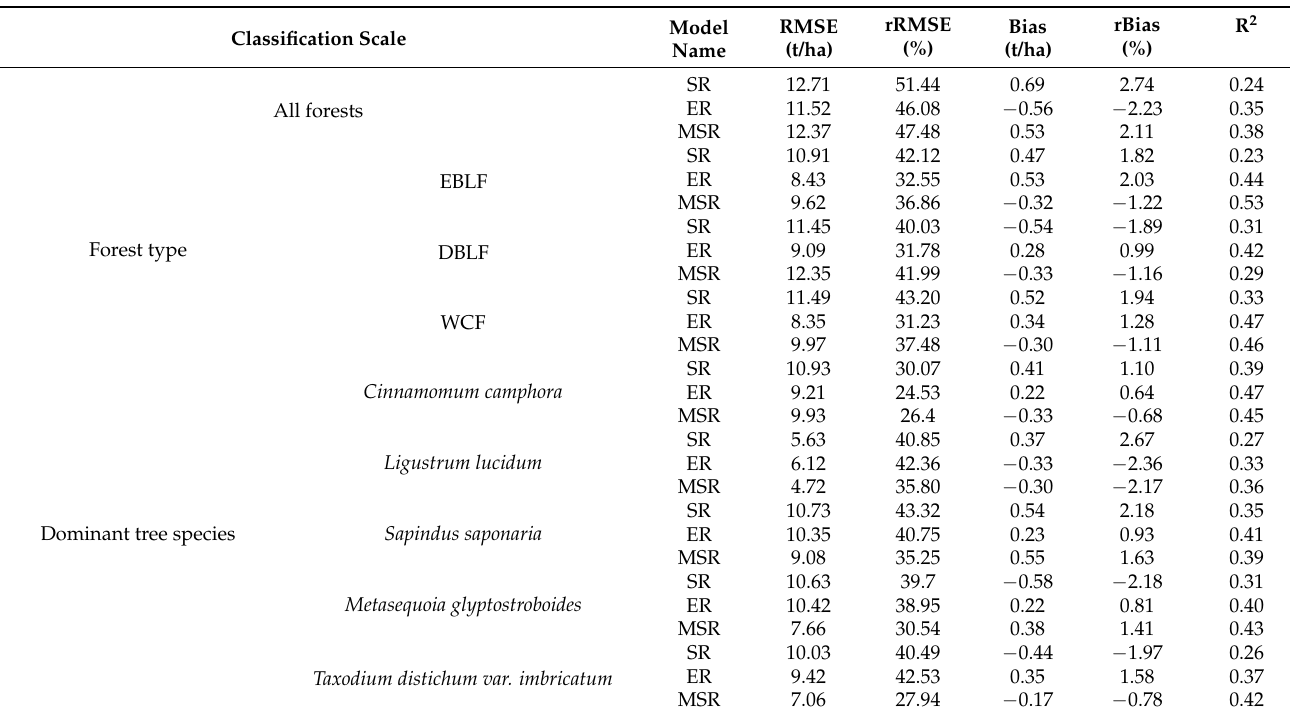
Table 2. Comparison of accuracy values of carbon density among different models and across different forest classification schemes. EBLF: evergreen broad-leaved forest, DBLF: deciduous broad- leaved forest, WCF: warm coniferous forest, SR: simple regression model, ER: exponential regression model, MSR: multiple linear stepwise regression